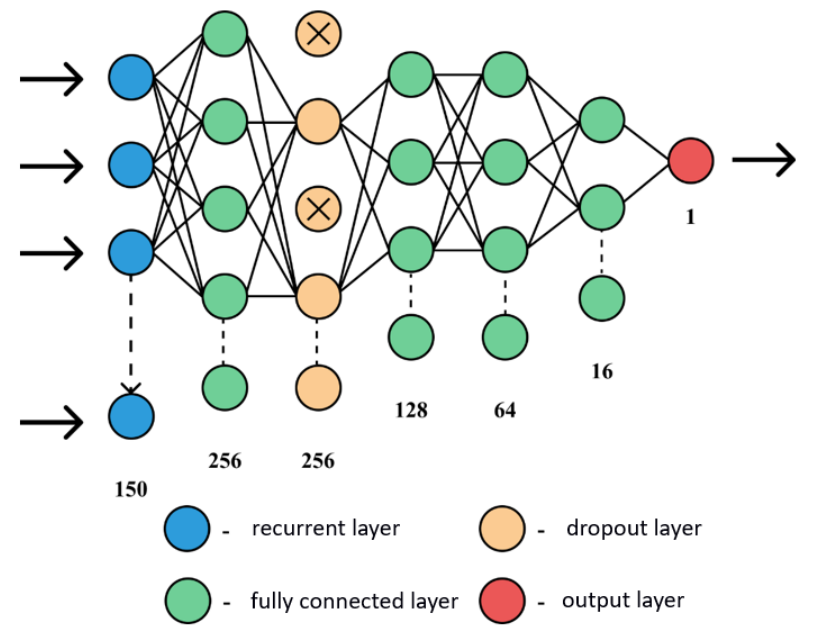
Figure 3. Architecture of the neural network for testing modules.